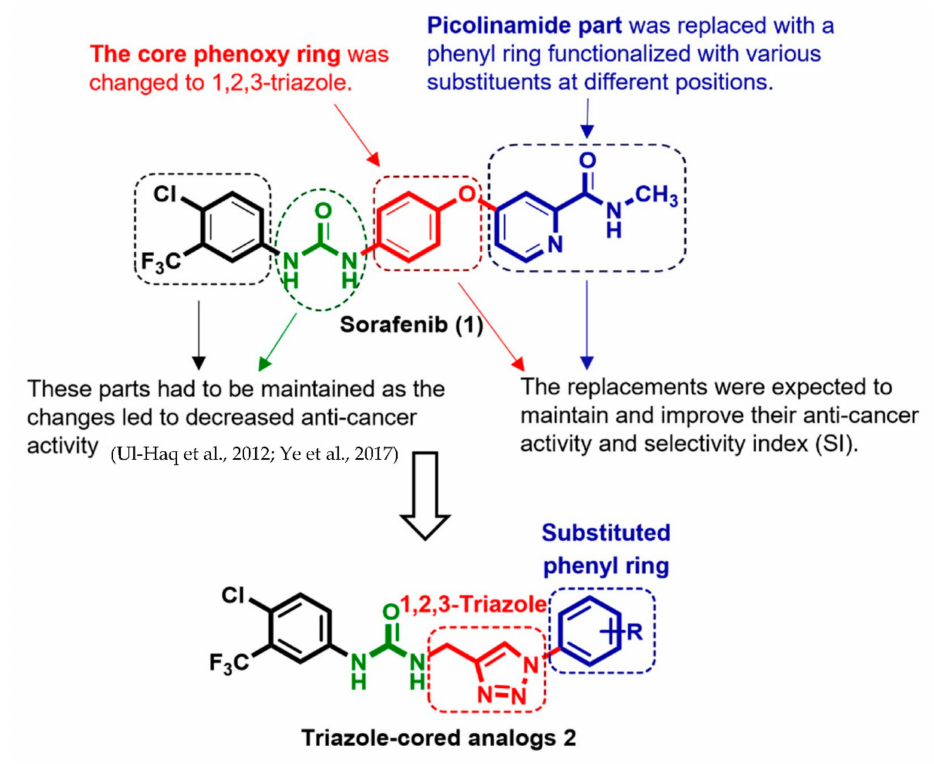
Figure 3. The structure of newly designed triazole-containing analogs 2 based on the modification of Sorafenib’s structure ( 1 )